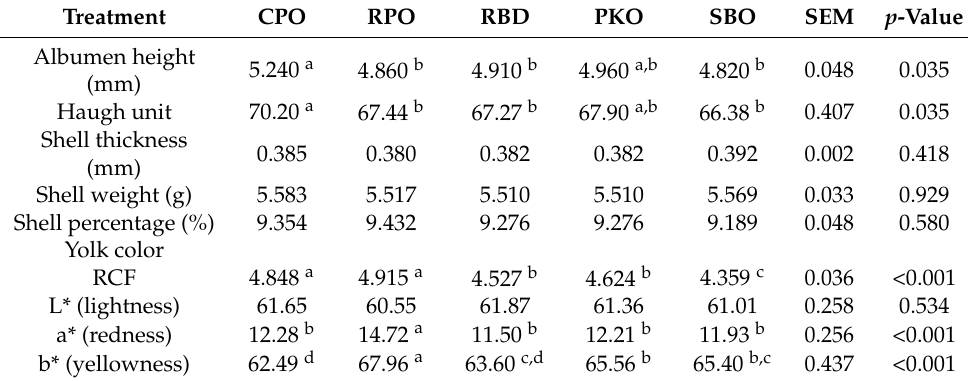
Table 4. Egg quality in laying hens fed different